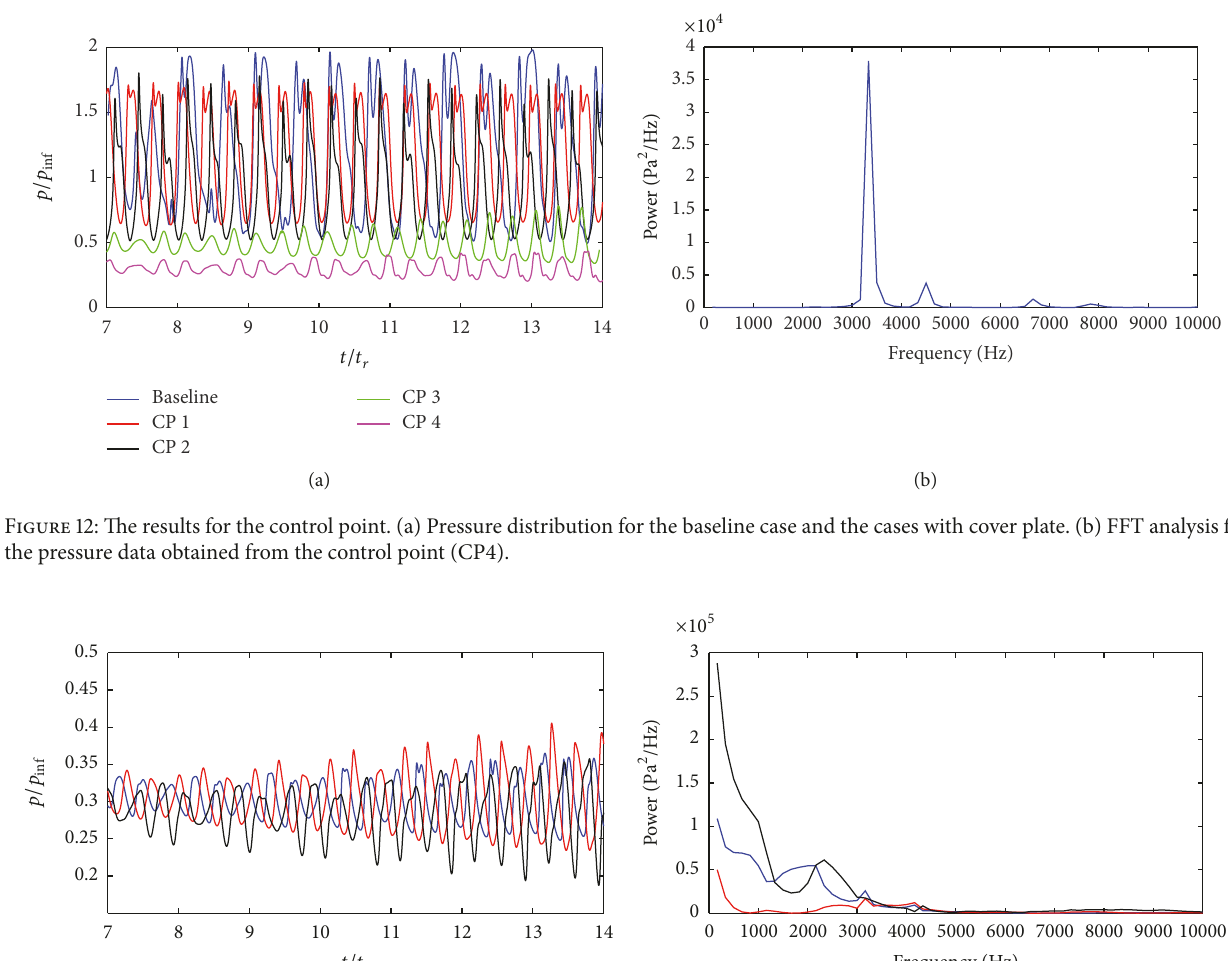
there is a clear shift in periods, as also shown in the FFT